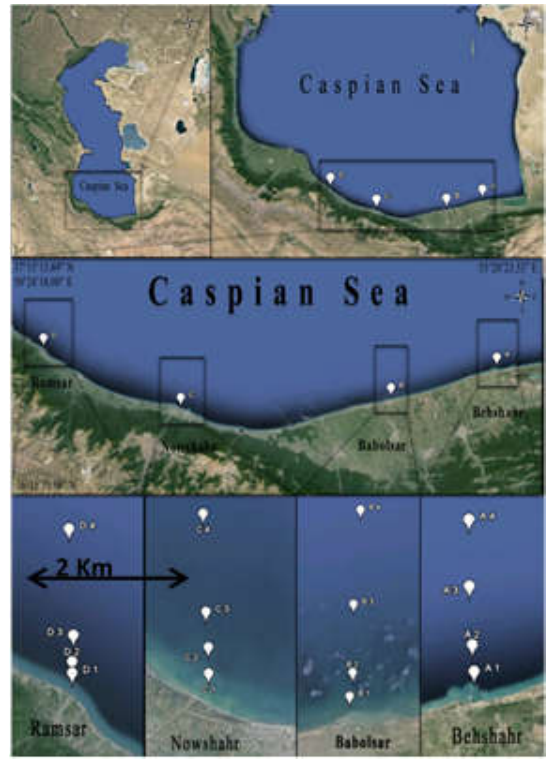
Fig 1: Situation of sampling stations in the Southern Caspian